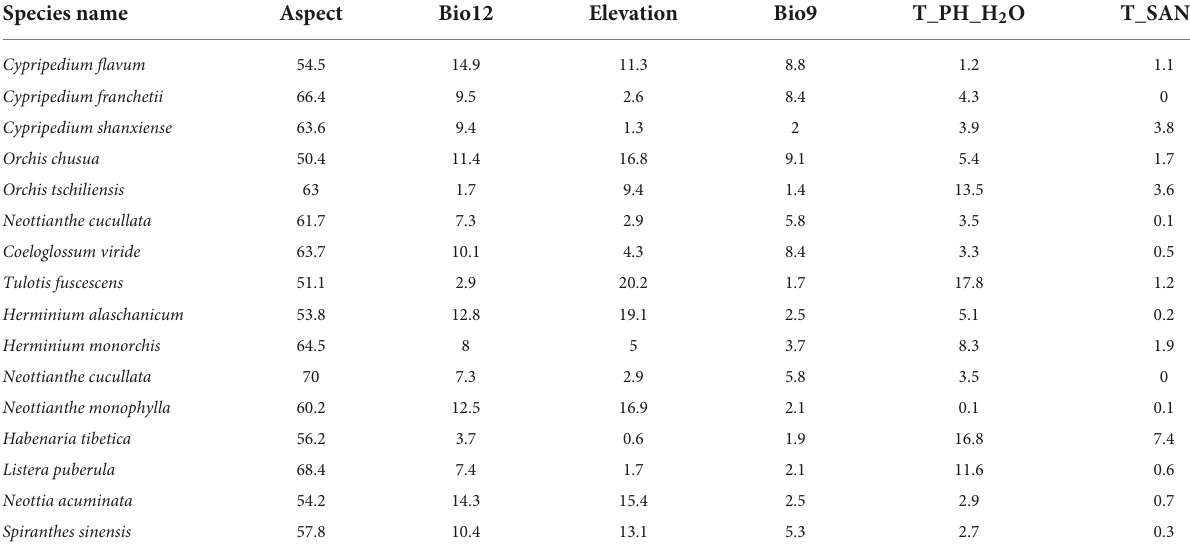
TABLE 3 The contribution (%) of environmental variables to the MaxEnt model output of 17 orchid species.